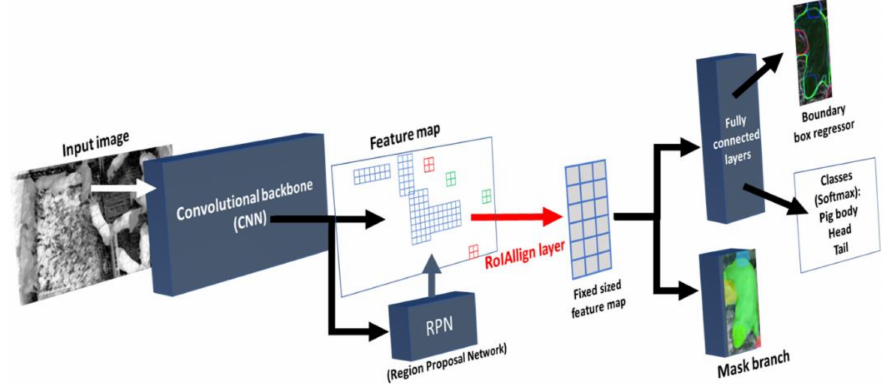
Figure 4. The Mask R-CNN framework for instance segmentation.